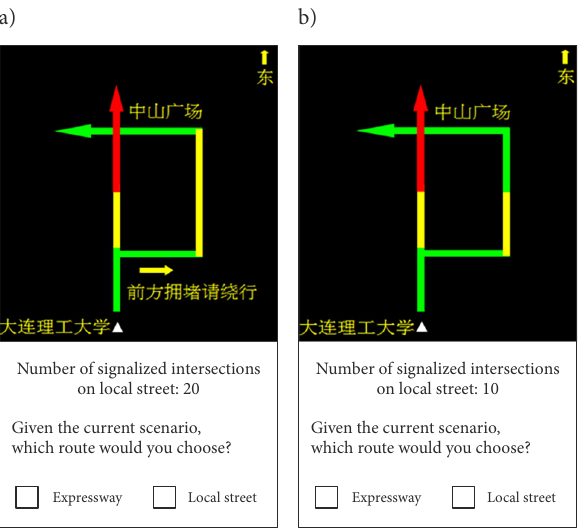
Figure 5. Examples of SP scenarios: a – information